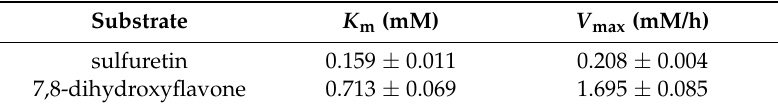
Table 3. Kinetic parameters of recombinant